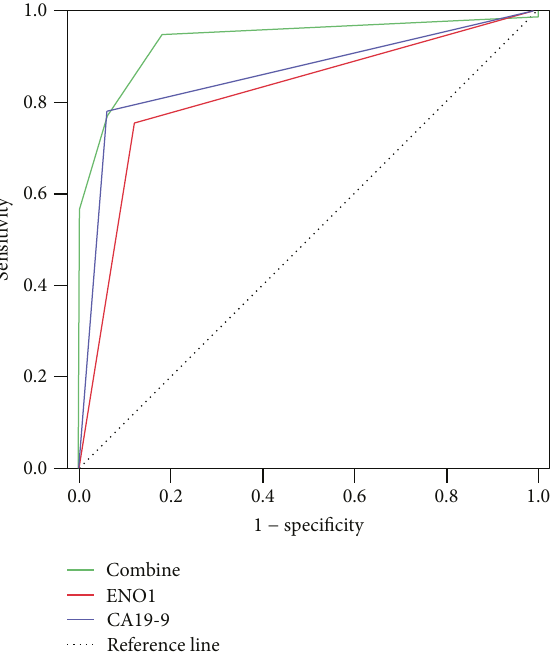
Figure 4: Diagnostic value of ENO1 single or combined with CA19- 9 for PDAC. ROC curves of CA19-9, ENO1, and a combination of both were shown with the median value of ENO1 used as cuto ff for diagnosing PDAC. P < 0 001